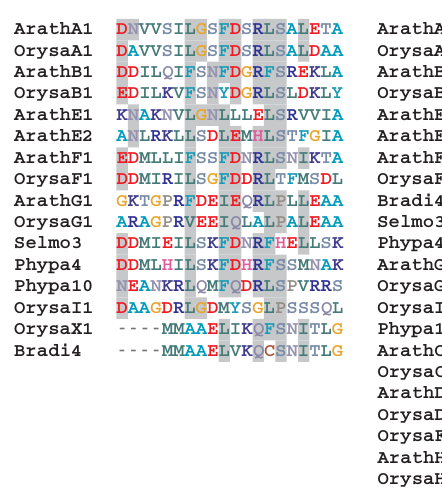
FIGURE 4 |Alignment of representative examples of the N-terminal conserved motifs found within the variable N-terminal part of Exo70 sequences. Motif 1 is located no more than 70 amino acids from the N terminus and always upstream of motif 2; motif 2 begins less than 250 amino